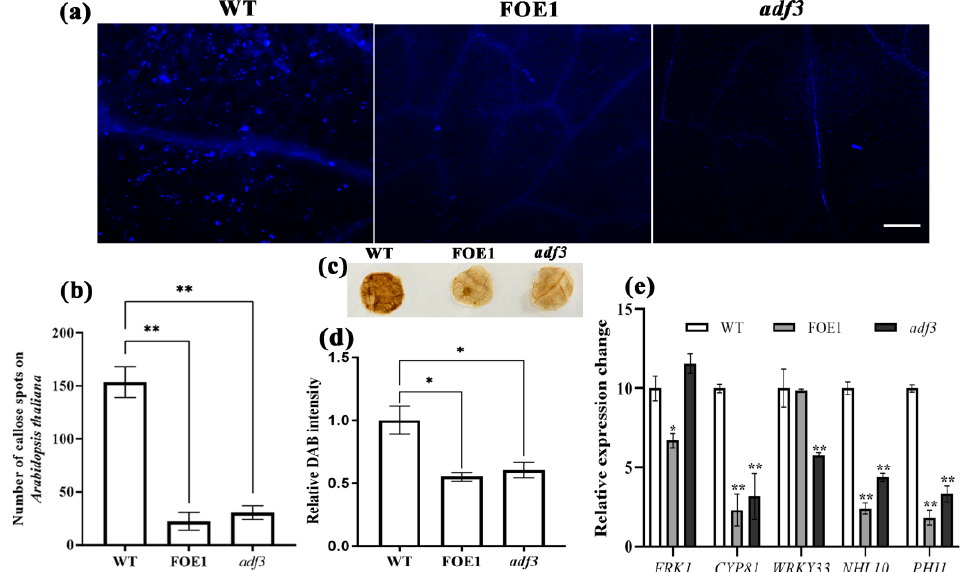
Figure 10. Callose deposition and ROS production was suppressed in leaves of Arabidopsis thaliana overexpressing Ab-FAR-1and adf3 mutant following flg22 treatment. ( a , b ) The callose deposition was suppressed in leaves of A. thaliana overexpressing Ab-FAR-1 and adf3 mutant following flg22 treatment. Bar=200 µ m. Values are presented as the means ± SE, n = 15. ( c , d ) The ROS production was suppressed in leaves of A. thaliana overexpressing Ab-FAR-1 and adf3 mutant following flg22 treatment. Values are presented as the means ± SE, n = 15. ( e ) The A. thaliana expressing Ab-FAR-1 and adf3 mutant suppresses the expression of defence genes in A. thaliana . The UBP22 was a reference gene. WT, wild-type Col-0 ecotype A. thaliana ; FOE1, Ab-FAR-1 overexpressing A. thaliana line 1#; adf3 , A. thaliana AtADF3 mutant. Values are presented as the means ± SE, n = 3. Asterisks indicate values that are significantly different (* p < 0.05, ** p < 0.01; t -test) from the WT.